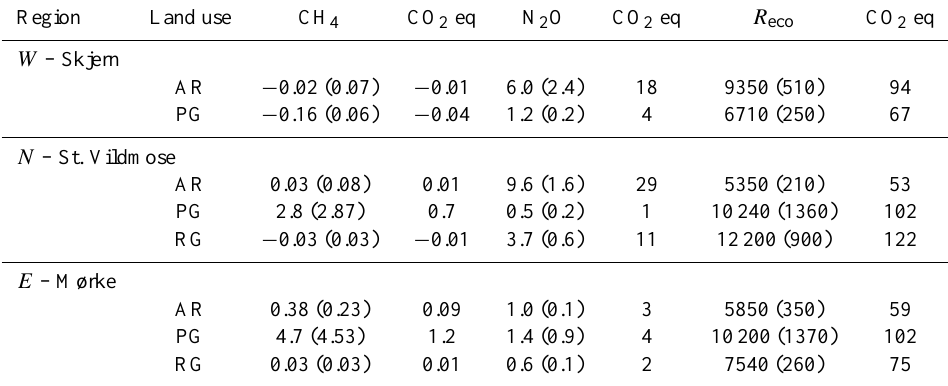
Table 5. Annual fluxes (gm − 2 ) of CH 4 , N 2 O and ecosystem respiration ( R eco ) for the period 21 September 2008 to 20 September 2009. Fluxes of CH 4 and N 2 O are also expressed as CO 2 equivalents (tha − 1 ) . The data represent mean ± standard error ( n = 6). AR – arable crop; PG – permanent grassland; RG – rotational